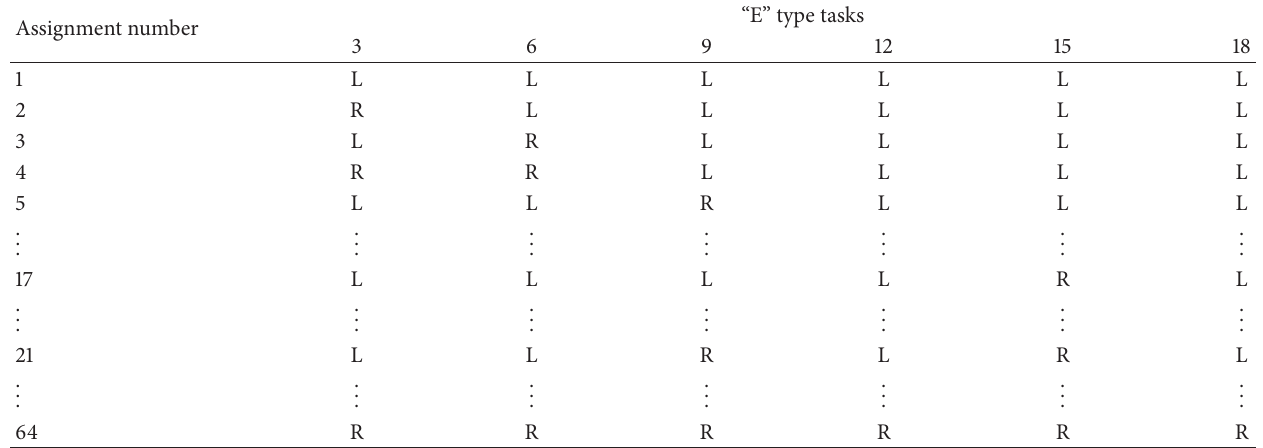
Table 2: Possible assignment of “E” type task to P19